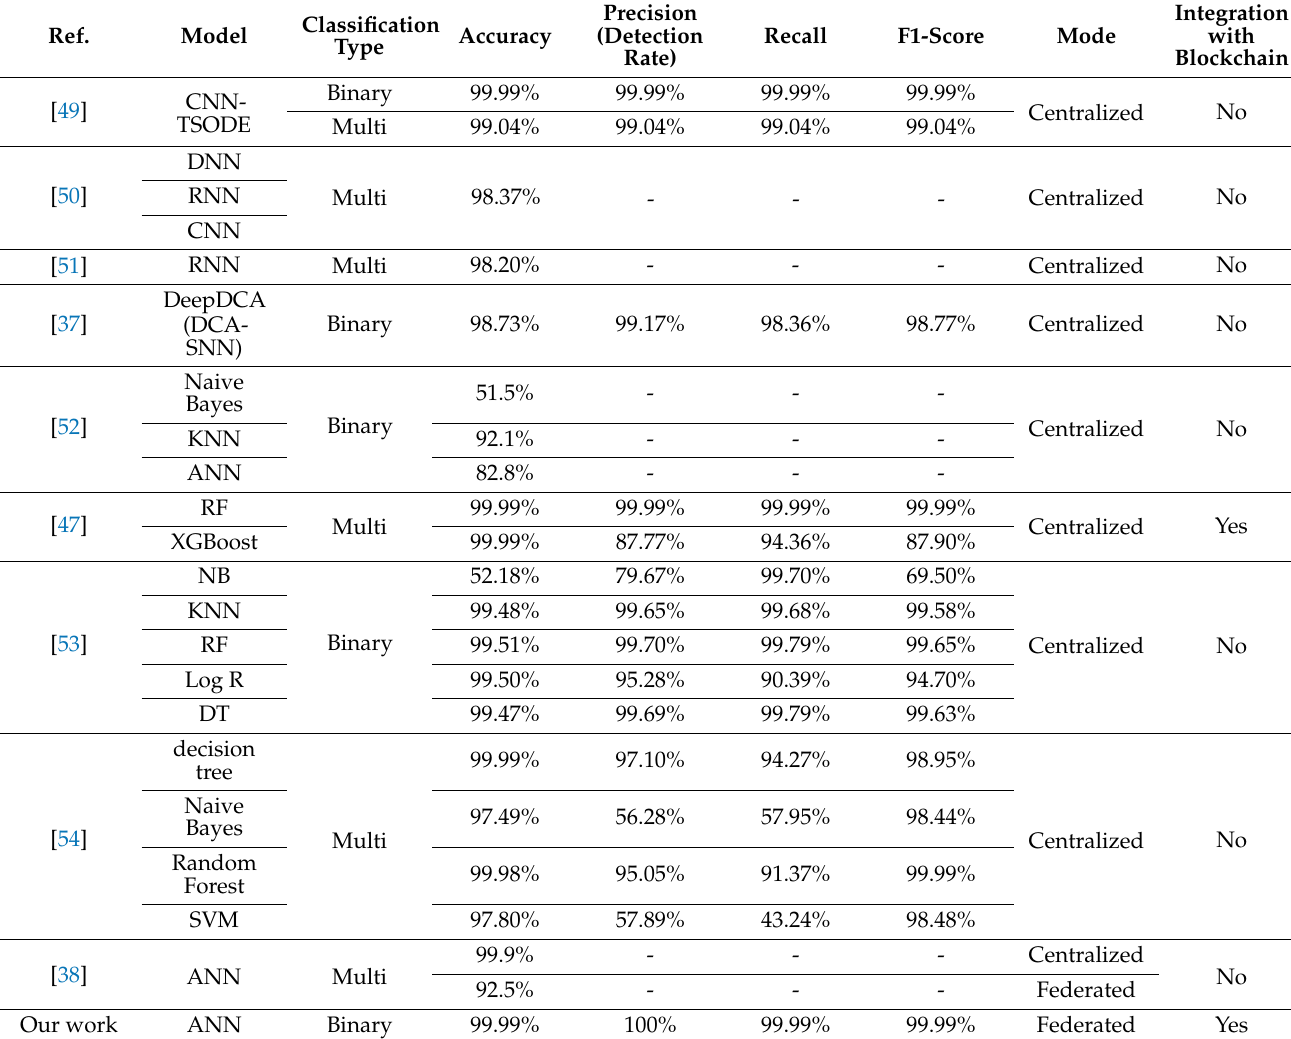
Table 5. Comparison with related work tested on BoT-IoT